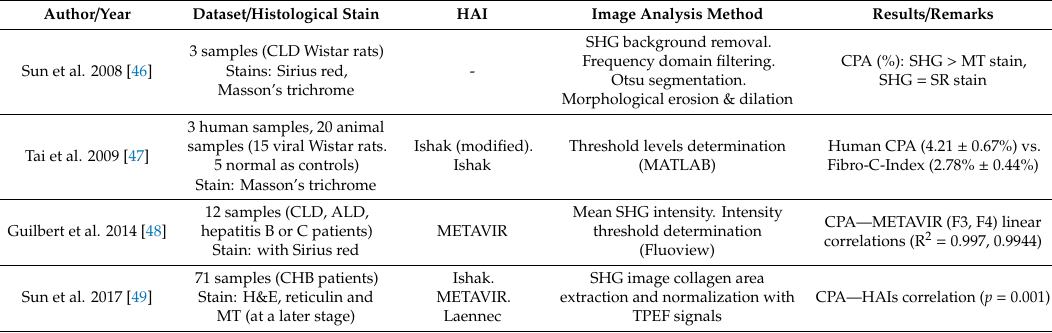
Table 4. Modern methodologies based on nonlinear SHG / TPEF imaging microscopy.